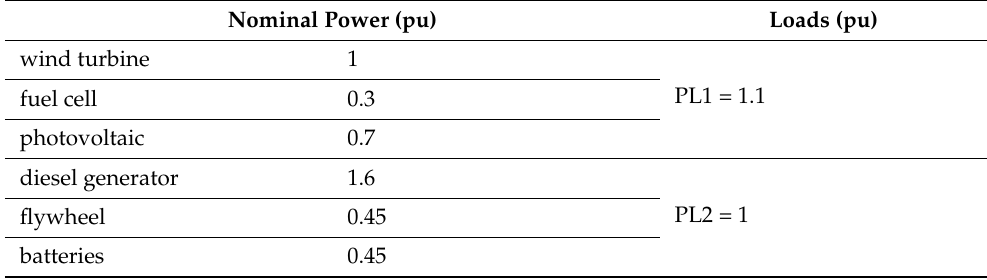
Table 2. Nominal microgrid power